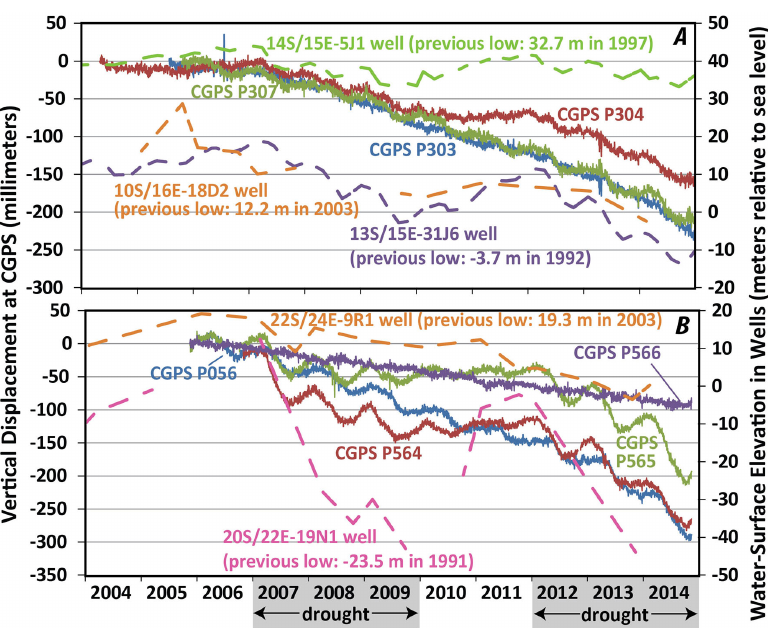
Figure 2. Graphs showing vertical displacement at selected CGPS stations and water-surface elevation in selected wells for 2004–2014 near